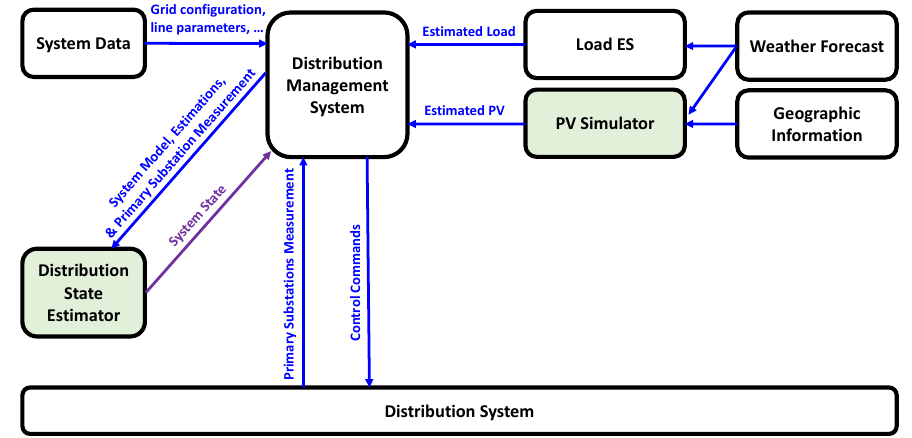
Figure 3. Proposed scheme for wide area monitoring in distribution systems with high PV